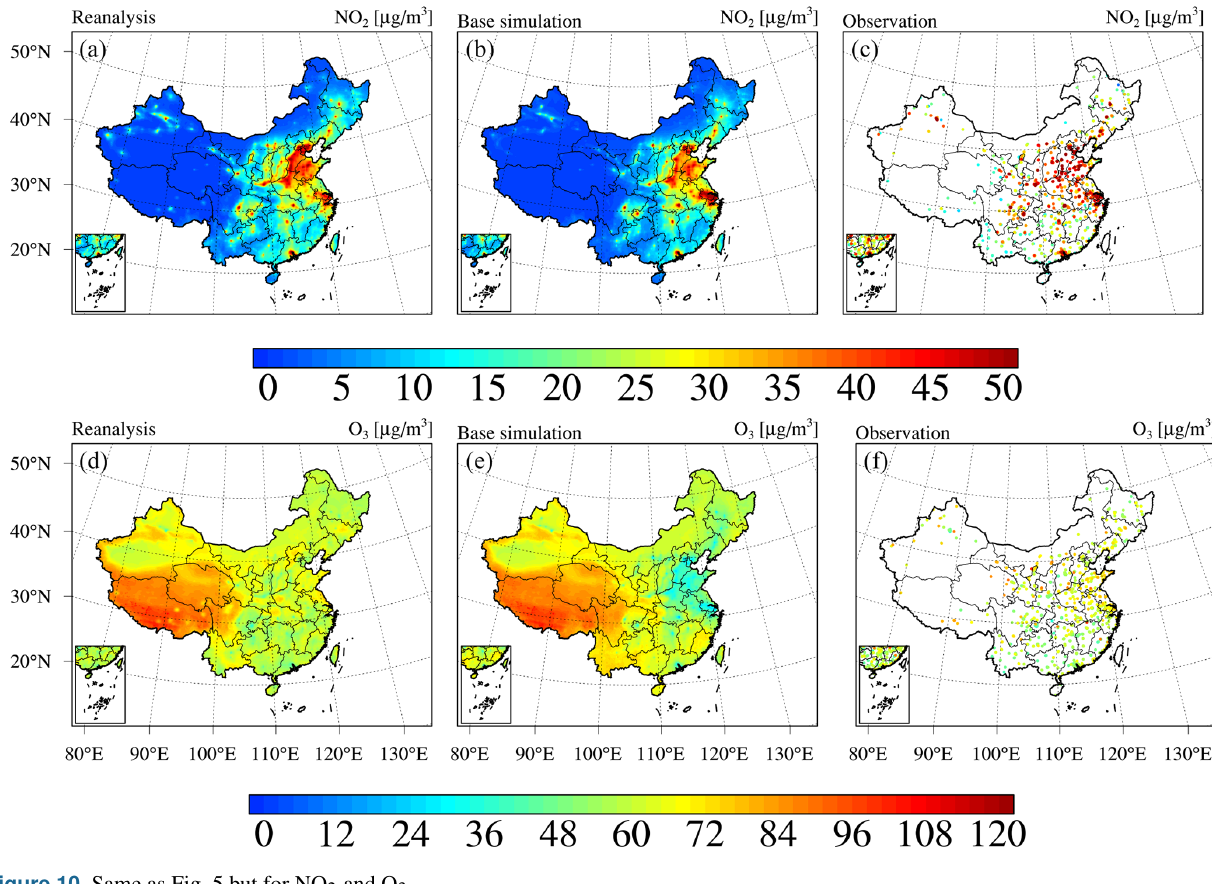
Figure 10. Same as Fig. 5 but for NO 2 and O 3 .